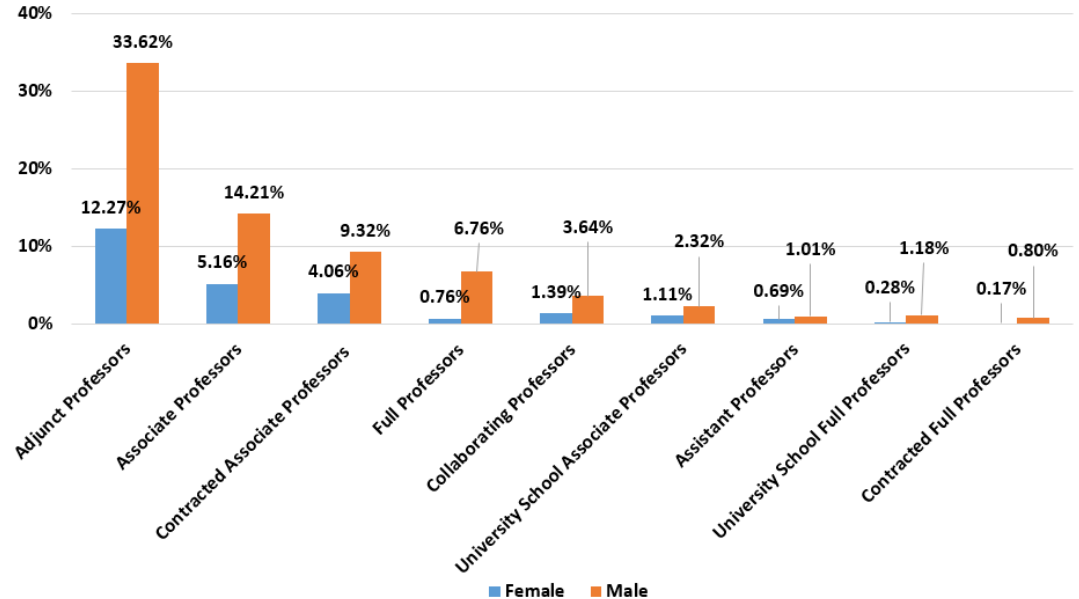
Figure 2. Distribution of the teaching and research staff of the Universitat Politècnica de Catalunya by job category and gender.